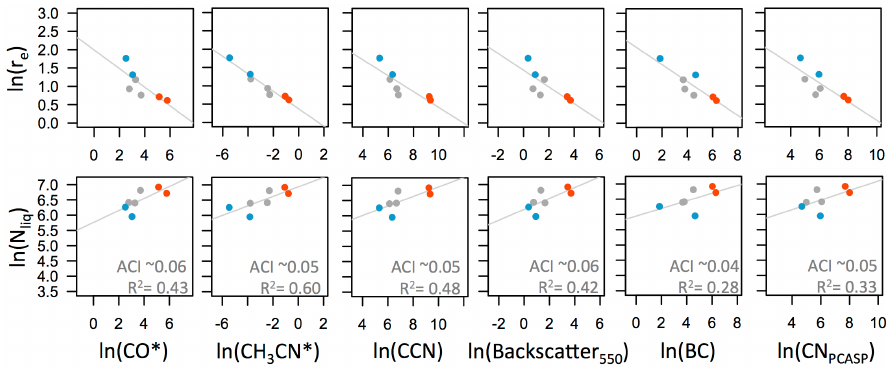
Figure 5. Based on seven samples from the ARCTAS-B 1 July 2008 case study, here we show the relationships between ln( r e ) (top row) and ln( N liq ) (bottom row) and ln(BB t ) derived from six indicators (where BB t = CO (ppbv) ( × indicates background values of 99.2ppbv have been subtracted), CH 3 CN (ppbv) ( × indicates background values of 0.088ppbv have been subtracted), CCN (cm − 3 ) , backscatter at 550nm (Mm − 1 ) , BC (µgCm − 3 ) , and CN PCASP equivalent values (cm − 3 ) , as calculated from UHSAS and APS measurements. Biomass burning samples are noted in red, and background samples are noted in blue. To show variation between tracers, linear regressions and associated ACI estimates are shown in light gray (but note that final ACI values are not derived from individual regressions, but rather a combination of all six tracers).